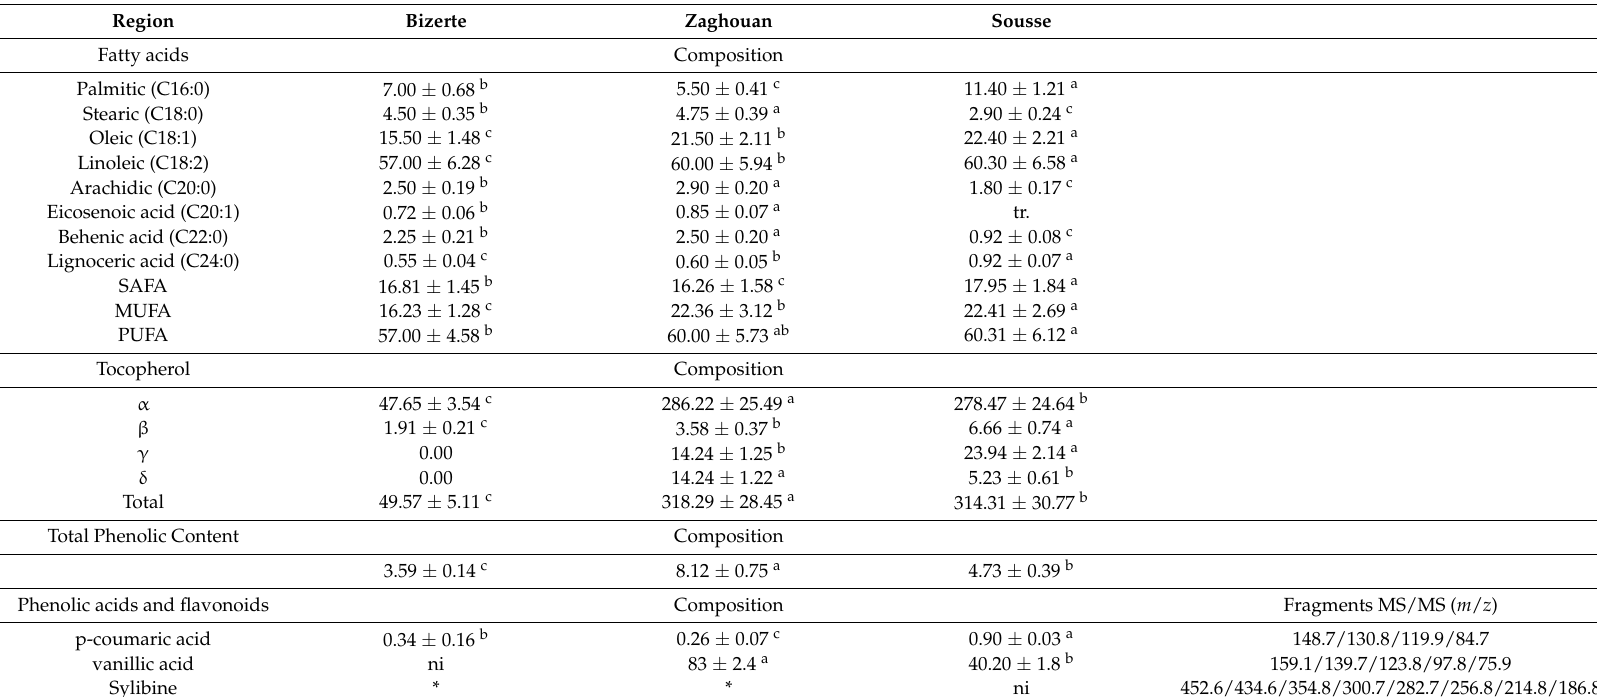
Table 2. Fatty acid (%) composition, tocopherol content (mg/kg oil), total phenolic content (mg GAE/g) and phenolic acids and flavonoids (mg/100 g) of milk thistle seed oils originating from